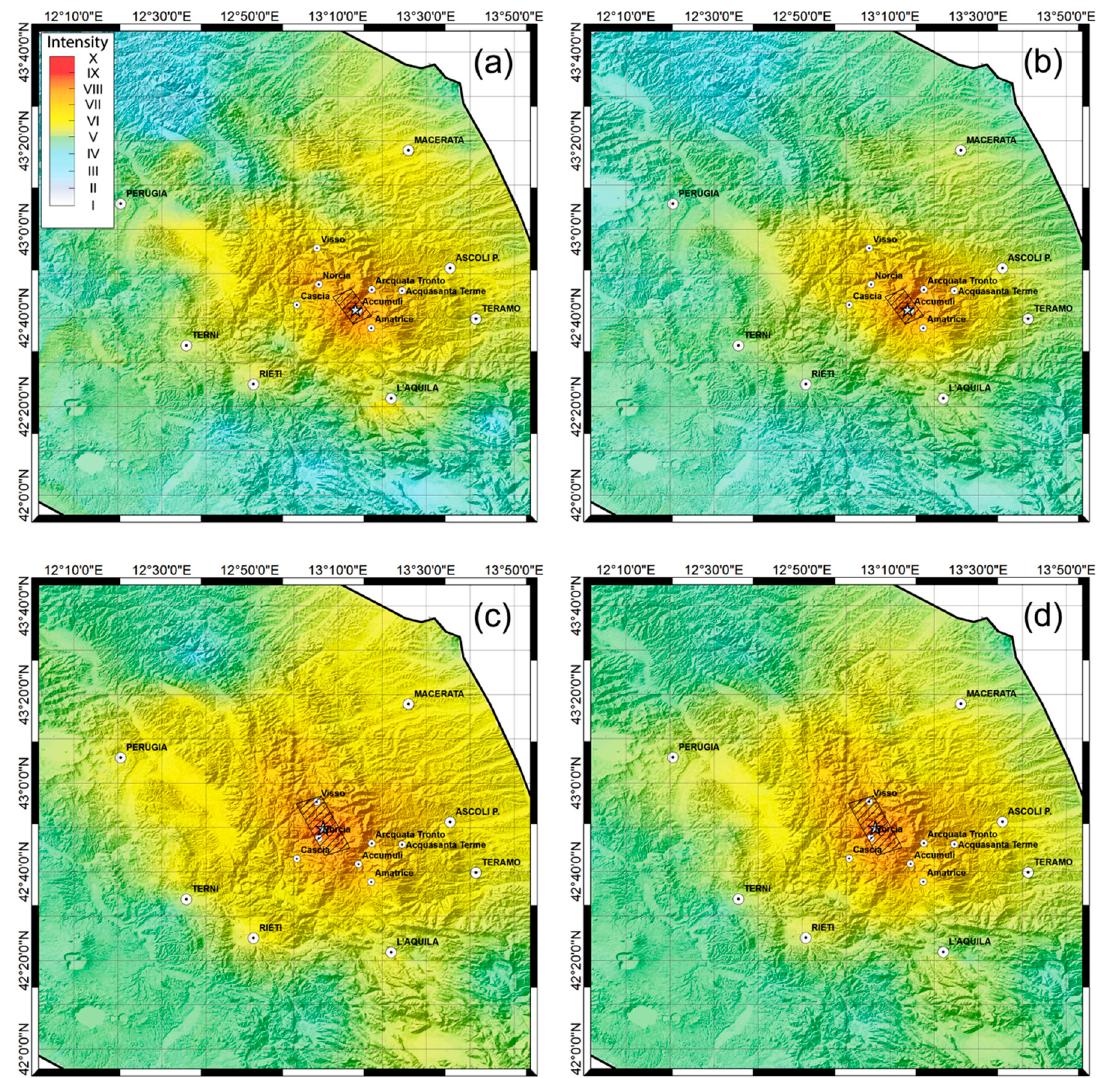
Figure 10. Intensity maps obtained through the model proposed by Tselentis and Danciu [29], which depend on the cumulative absolute velocity ( a , c ) or Arias intensity ( b , d ) and the epicentral distance: M W 6.0 Amatrice ( a , b ) and M W 6.5 Norcia earthquakes ( c , d ).